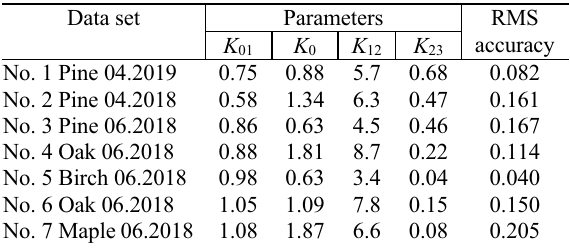
Table 3. Fitted amplitude parameter values of the compact model for each of the seven experimental data sets